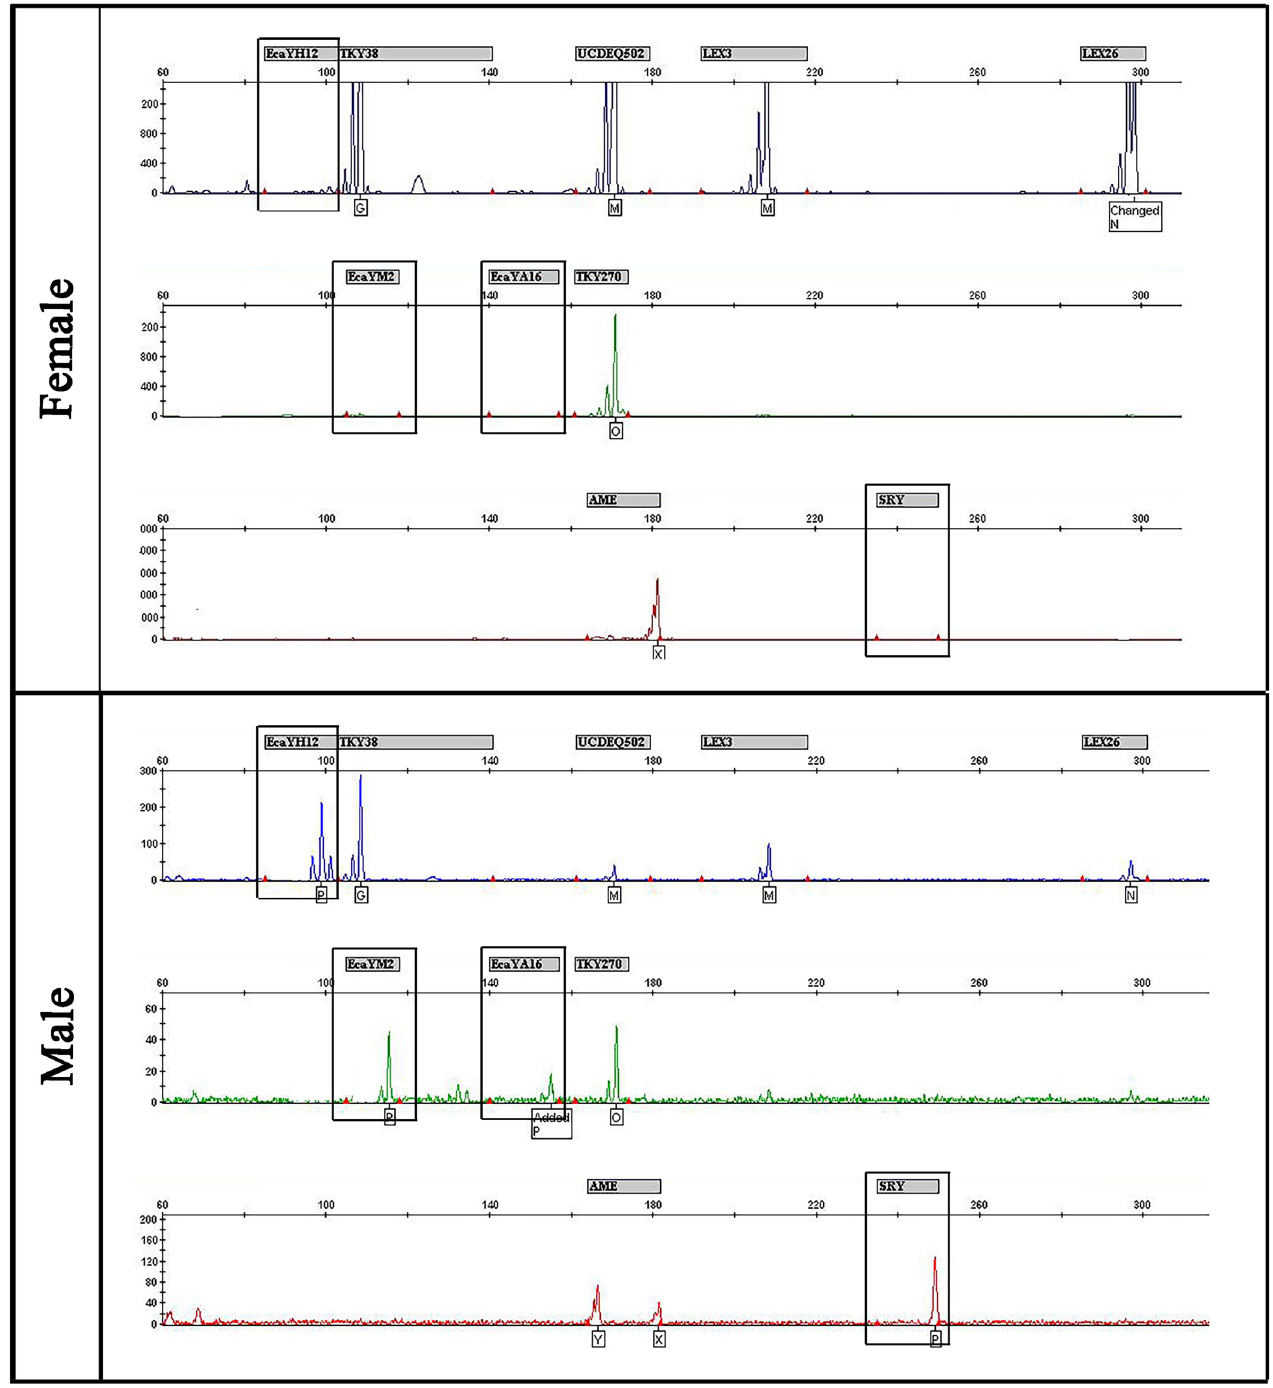
Fig 5. Characterization of X- and Y-linked markers. Results of microsatellite analysis in the female and male horses. Boxes indicate the Y-linked markers.